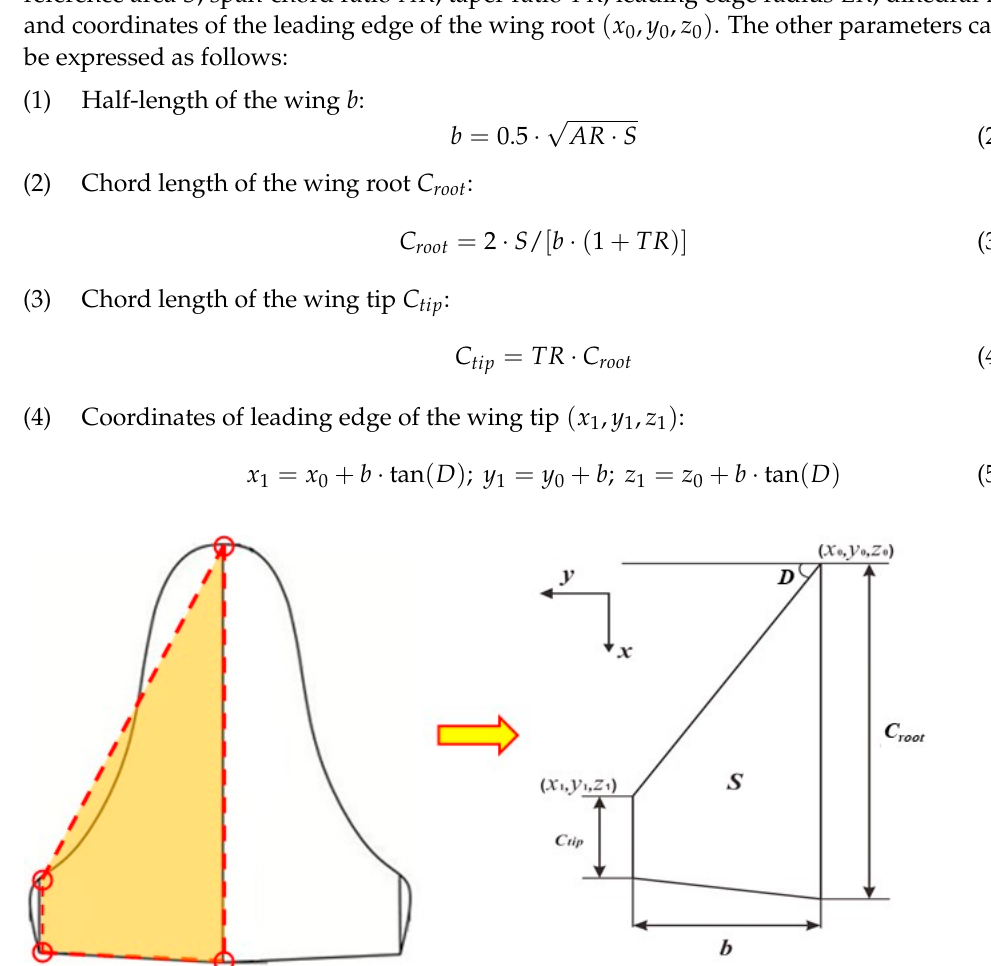
Figure 2. Profile of the hypersonic vehicle. ( a ) Planar graph; ( b ) Fitted profile.